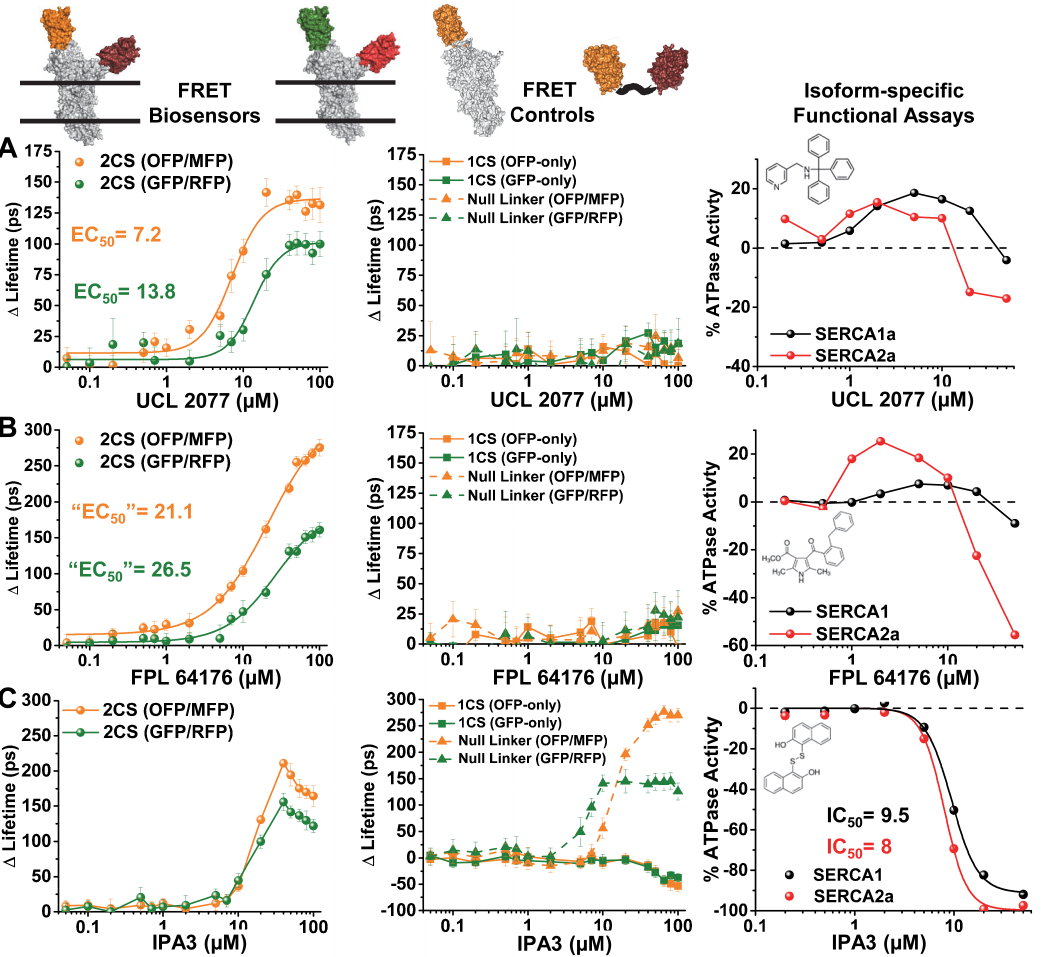
Figure 5. Structural and functional assays of reproducible LOPAC hits for human SERCA2a, showing concentration-response curves (CRC): ( A ) UCL 2077, ( B ) FPL 64176, and ( C ) IPA3. The first two columns show FRET-based lifetime changes for the 2CS biosensor (left) or the donor-only 1CS and null linker control cell lines (middle). The right column shows functional data (SERCA Ca-ATPase activity). The dashed line indicates the baseline ATPase activity without addition of compound. Compound structures are shown as